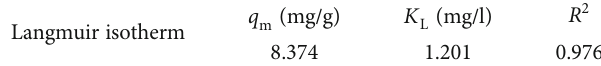
Table 1: Langmuir isotherm parameters. Langmuir